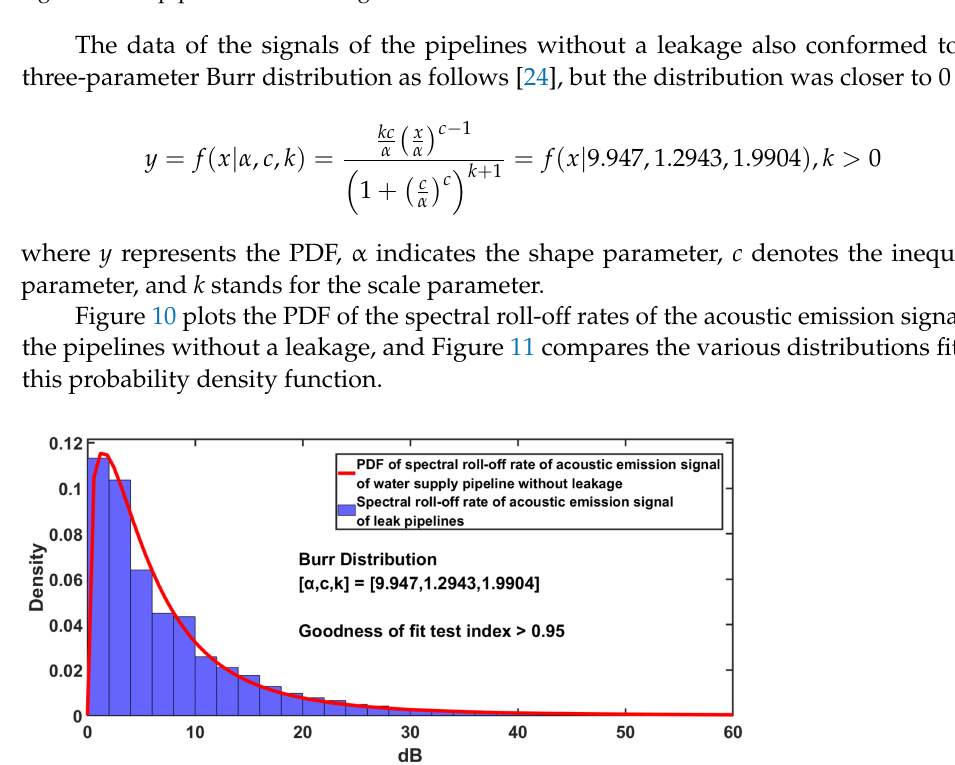
Figure 9. Comparison of the distributions fitting the spectral roll-off rates of the acoustic emission signals of the pipelines with leakage.